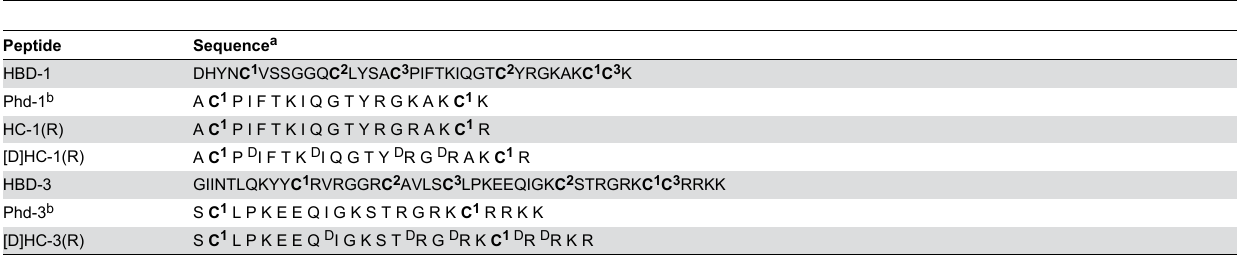
Table 1. Primary structure of HBD-1 and-3 and their analogs.